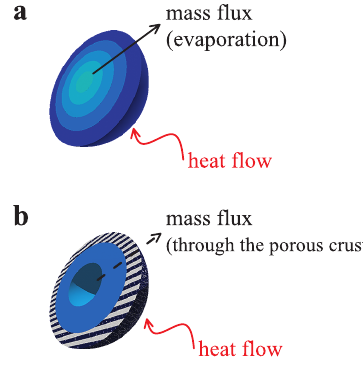
Fig. 3 Scheme of the multiple shell model of (a) a dried droplet and (b) a wet particle with solid crust (marked in black and white), wet core and a gas bubble